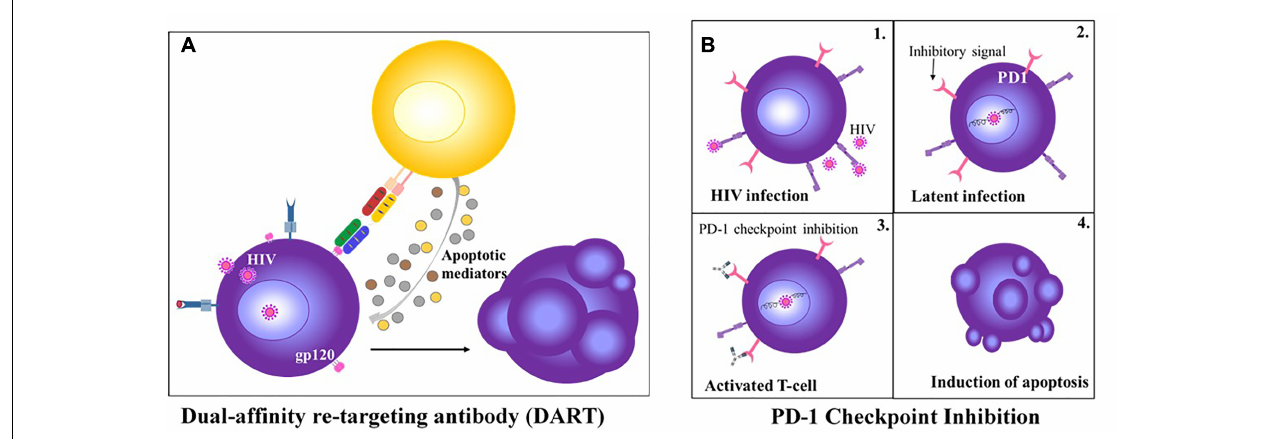
FIGURE 2 | HIV-targeting T cell Therapies. (A) Anti-CD3 and anti-gp120 DART treatment redirects CD8+ T cell to kill HIV infected CD4+ T cells (Perreau et al., 2017). (B) PD-1 check point inhibition of latently infected CD4+ T cell results in re-activation of the T cell and induction of apoptosis (Wykes and Lewin,